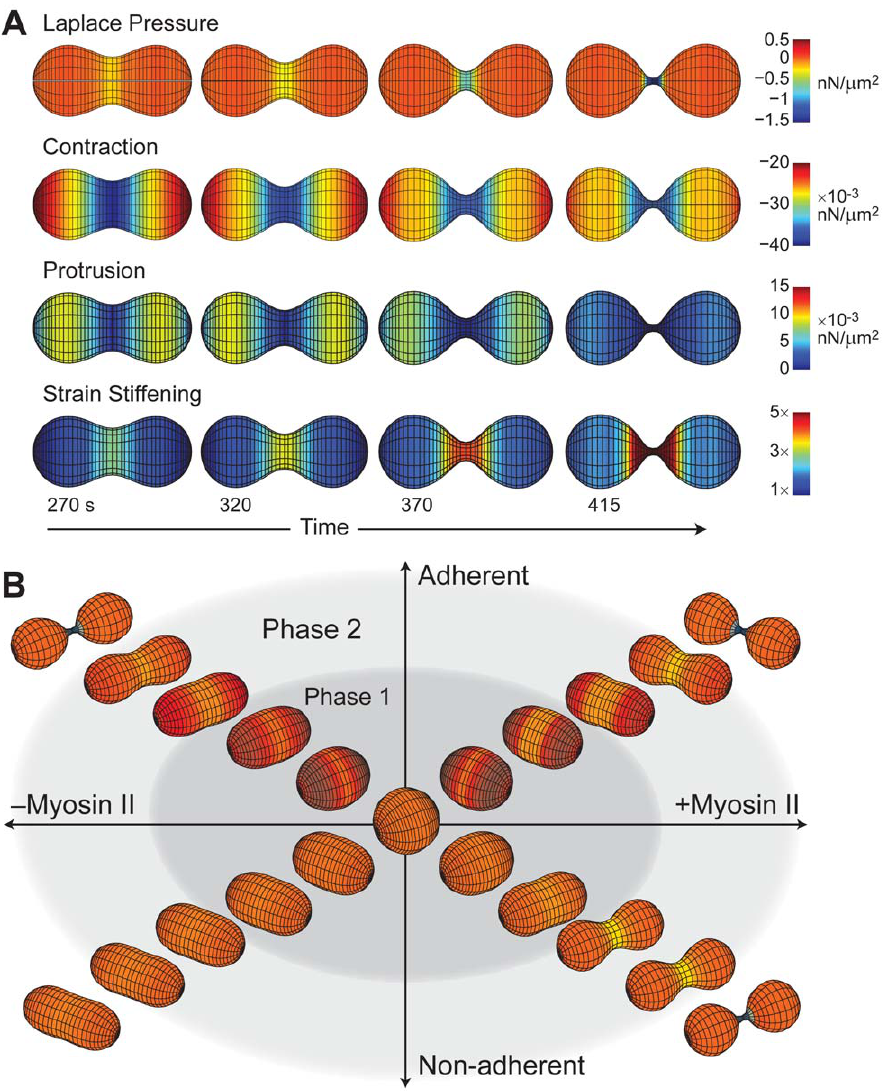
Figure 5. Distribution of stresses acting on the cell. A. Temporal and spatial profiles of different stresses in WT simulation at various time points. Negative stresses denote inward-directed forces. B. Summary of phenotypes observed in the simulations separated by the different conditions applied. Phase 1 denotes the initial breaking of spherical symmetry. Phase 2 is the progression into a dumb-bell shape.